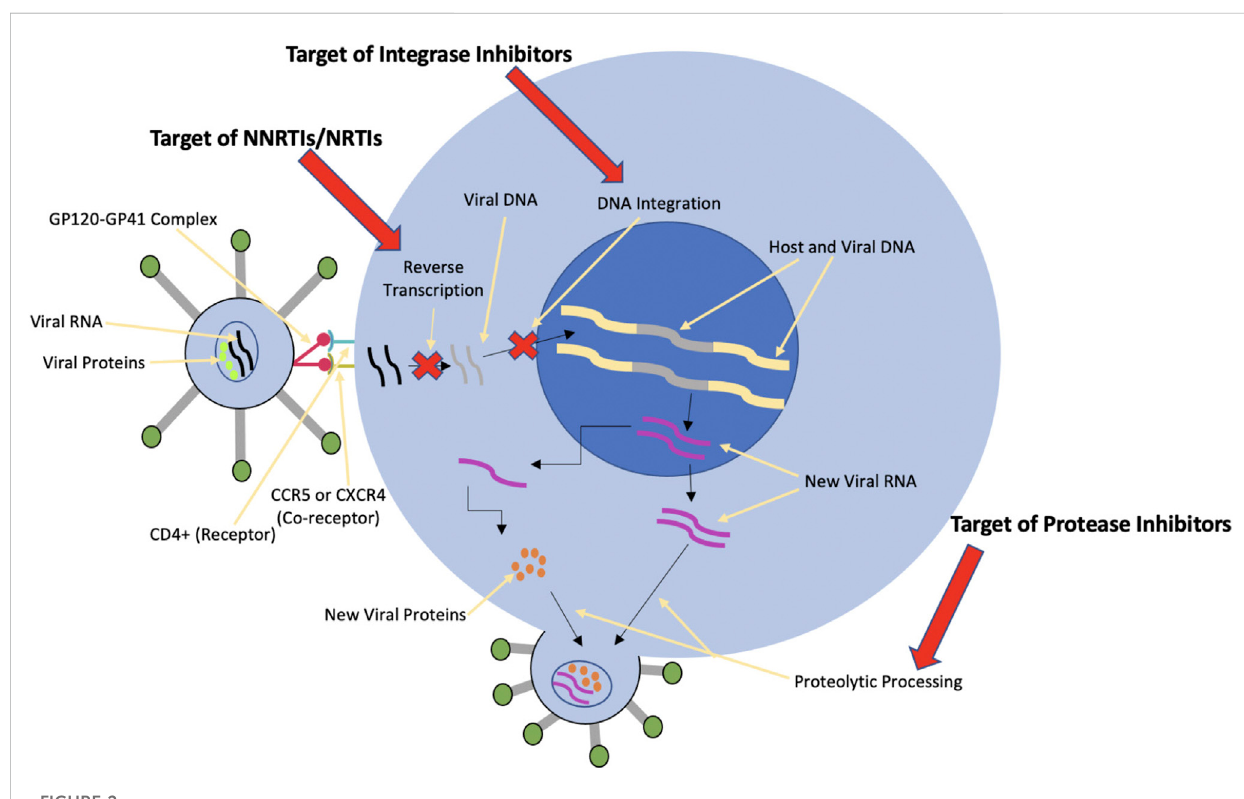
FIGURE 2 Combined Graphic of action of all cART drug